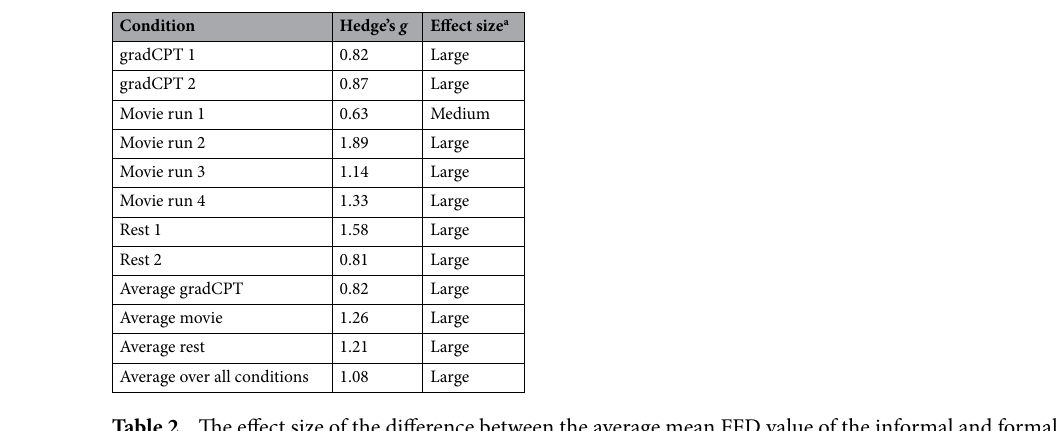
Table 2. The effect size of the difference between the average mean FFD value of the informal and formal mock scan groups. a We used the following criteria for effect size interpretation: small (g ≥ 0.2), medium (g ≥ 0.5), and large (g ≥ 0.8) 38 .